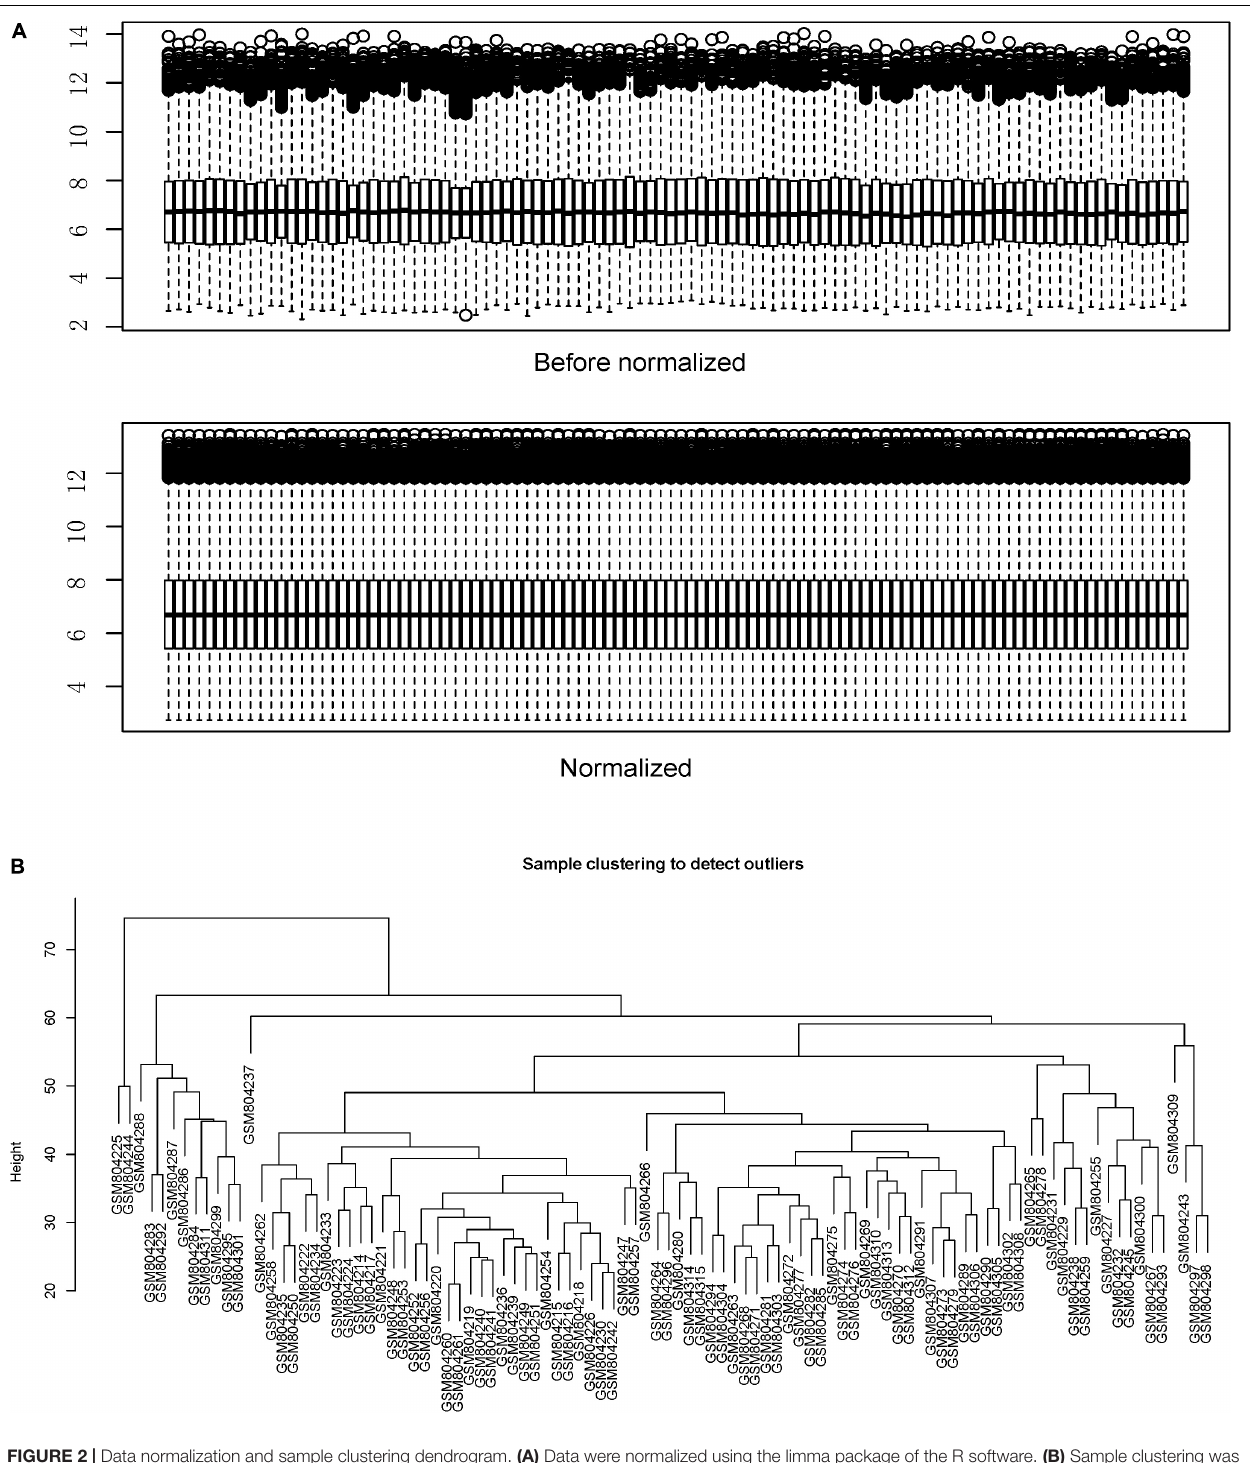
levels of candidate hub genes in this module were significantly increased in different BPD severity conditions compared with those of normal controls. In contrast, candidate hub genes